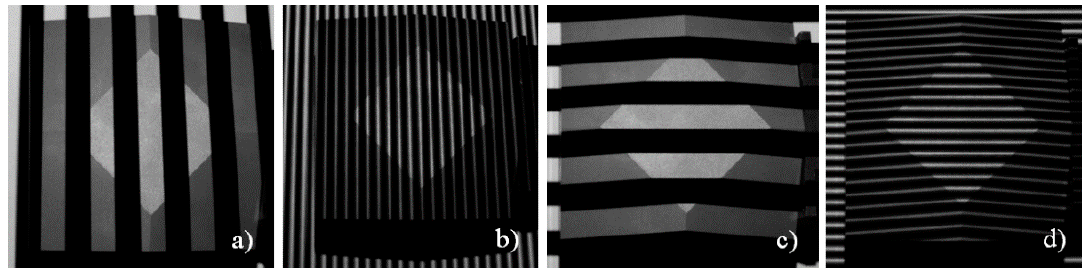
Figure 4. Selected images from fringe sequence: parts of Gray-code sequence ( a , c ) and sinusoidal fringes ( b , d ) taken from air measurements of a frustum of a pyramid.